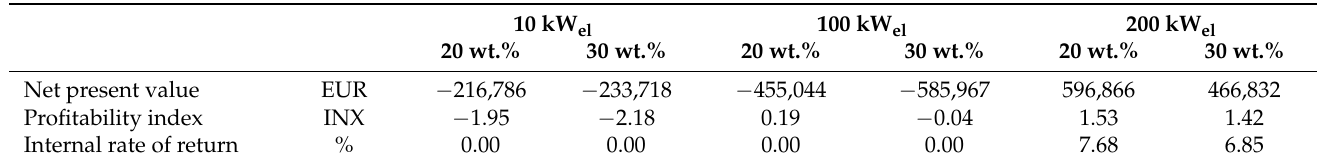
Figure 3. Discounted cash flow (blue) and cumulative discounted cash flow (orange) in 15 years after investment in the 200-kW el variant. Table 9. Dynamic investment indexes.